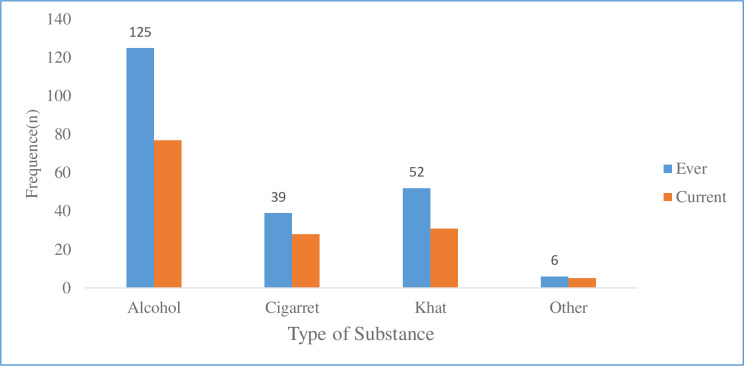
Types of substances used by study participants attending ART clinic at HUCSH, SNNPR, Ethiopia, 2019 (n = 389).